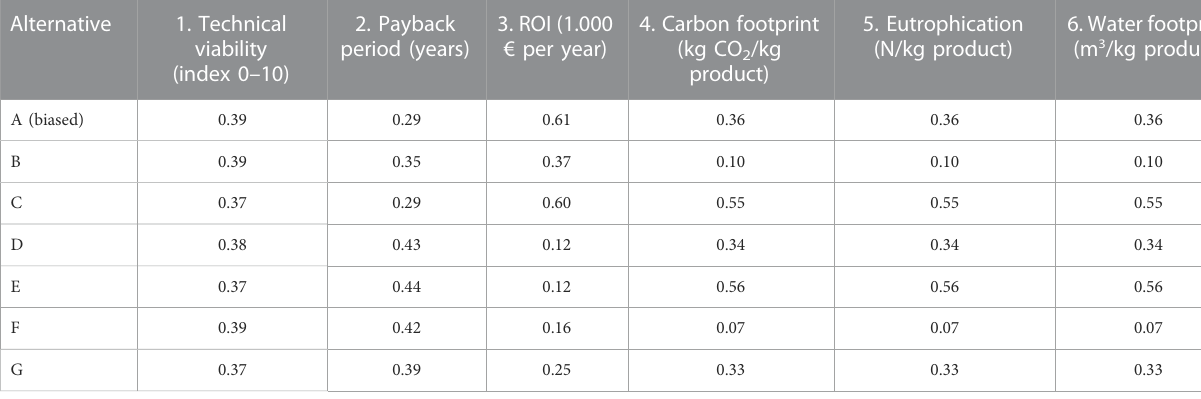
TABLE 5 Normalized decision matrix for Company A.